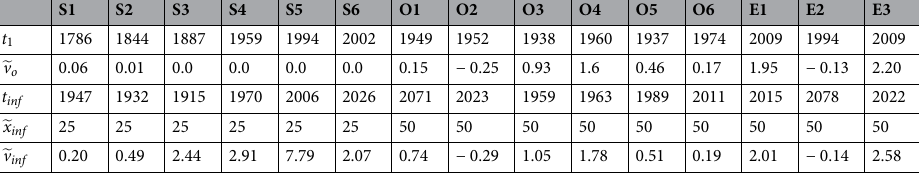
Table 3. Kinematic values for logistic fits to poll data, including initial time t 1 , initial velocity, (cid:31) v o , and values at the inflection point, t inf , (cid:31) x inf , and (cid:31) v inf .